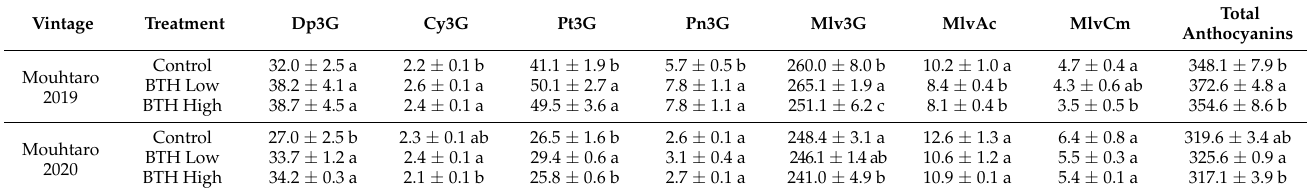
Table 8. Individual anthocyanins evaluated by HPLC in Mouhtaro